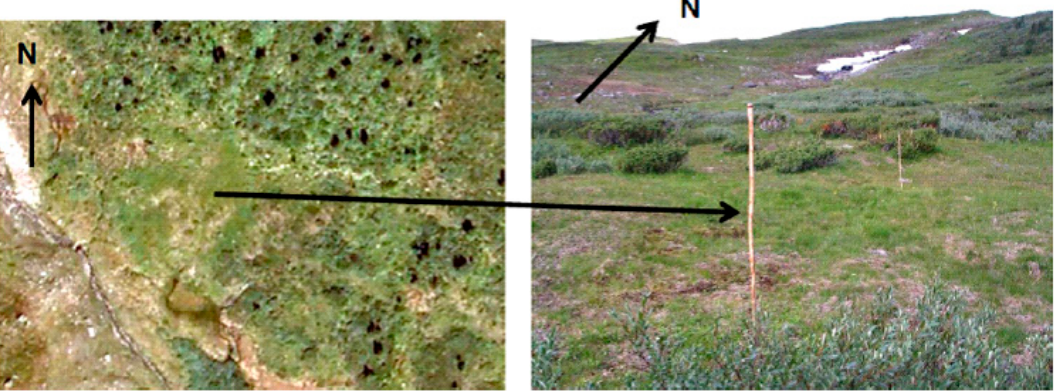
Figure 2. Reindeer milking landscape (buhtjeme-aevieh) in Byrkije 80–90 years after milking practice ceased. Aerial image (Statens kartverk) on the left and ground picture taken by Sigbjørn Dunfjeld to the right [65].